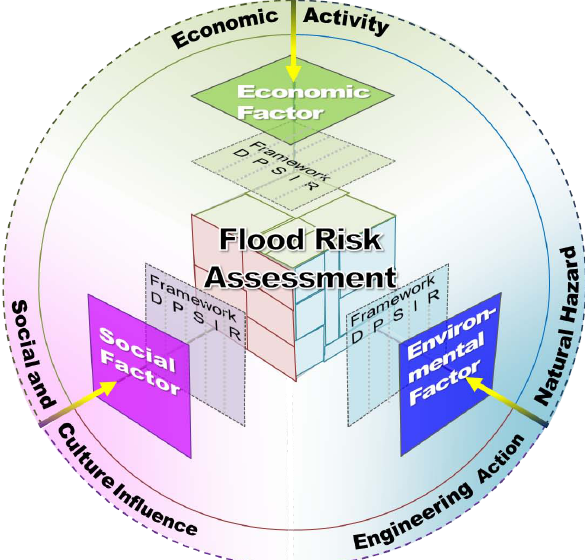
Fig. 2. Procedure of this study. them (for example, amount of social overhead capi- tal